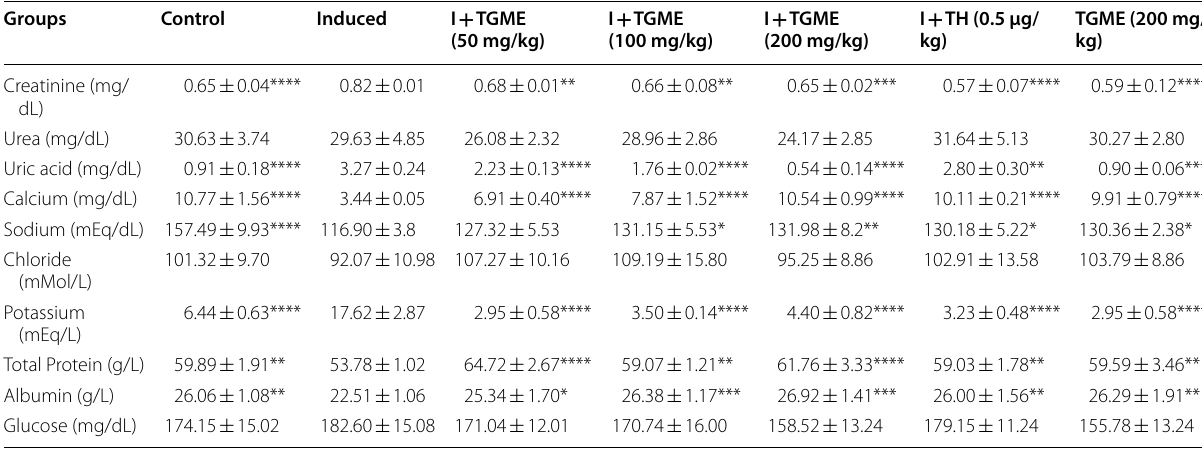
Table 6 Effect of aqueous methanolic leaf extract of Triclisia gilletii on plasma biochemistry parameters in animals administered ethane-1,2-diol